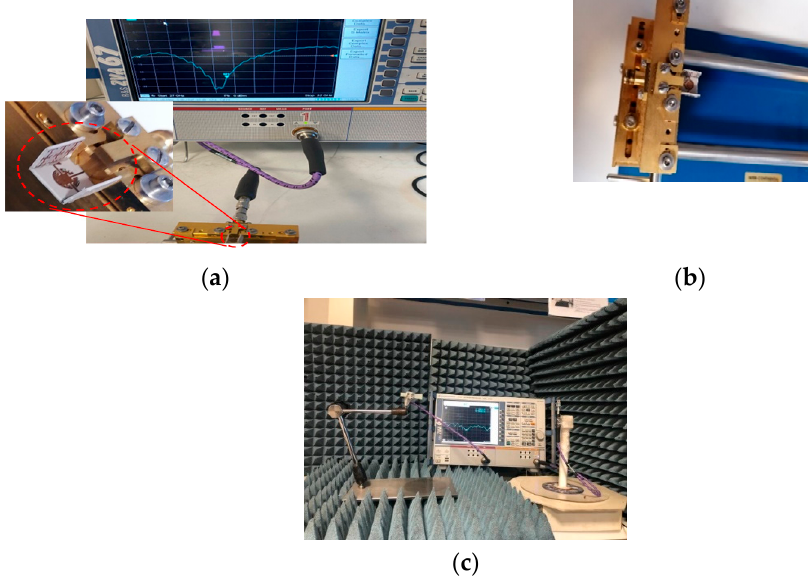
Figure 12. Fabricated antenna prototype. ( a ) Measurement setup of scattering parameters ( b ) Photo of the proposed antenna connected to the test fixture ( c ) Measurement setup of radiation patterns.